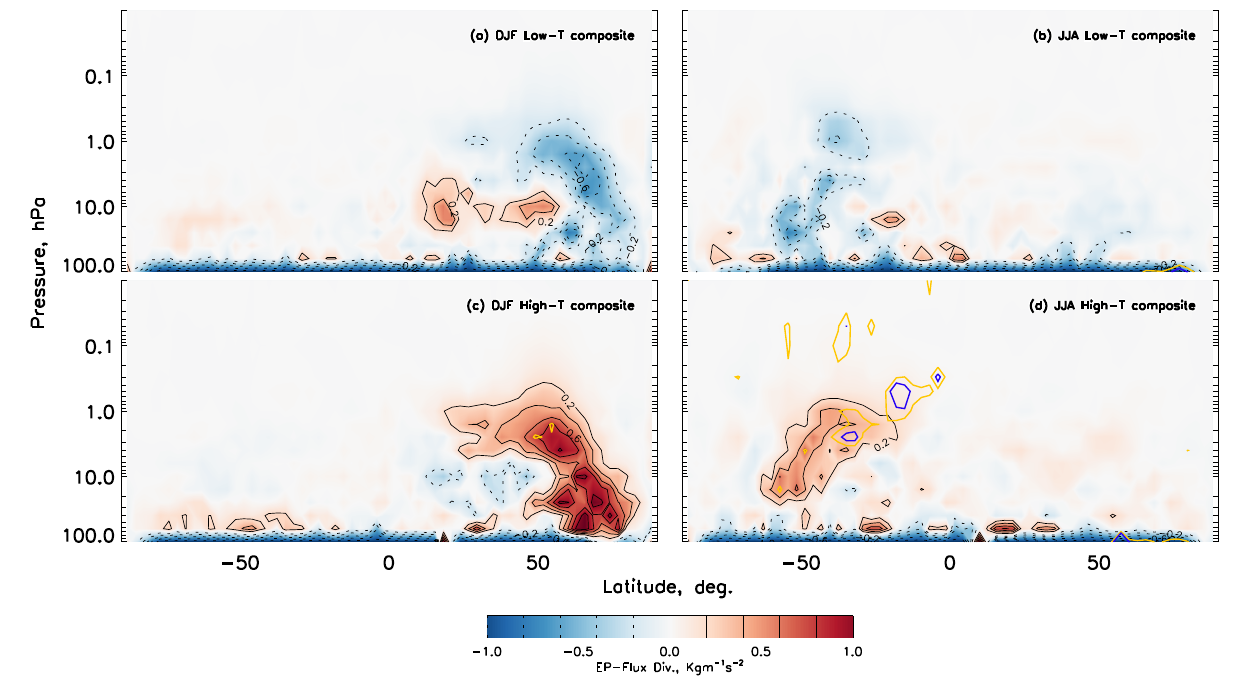
Figure 6. As for Fig. 5 but for EPFD. Negative values indicate increased wave activity, and positive values decreased activity.